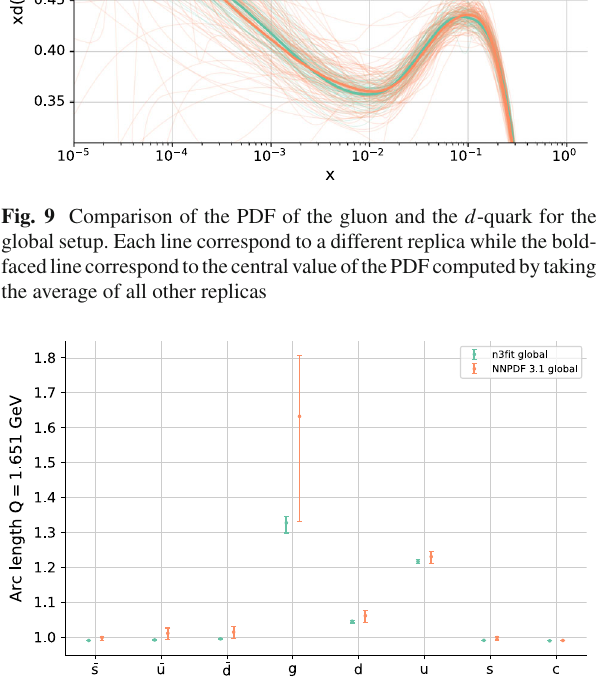
Fig. 10 Comparisonfortheglobalsetupofthearc-lengthsbetweenthe new and old methodologies. As in the DIS setup, the new methodology produces smoother curves with smaller and more stable arc-lengths ence between the old and new methodology in the global setup is not as evident as in the DIS only case, we can still observe more stable replicas and in general smoother curves in Fig. 9, where we plot all produced replicas for the new and old methodologies for the gluon and d -quark PDFs.